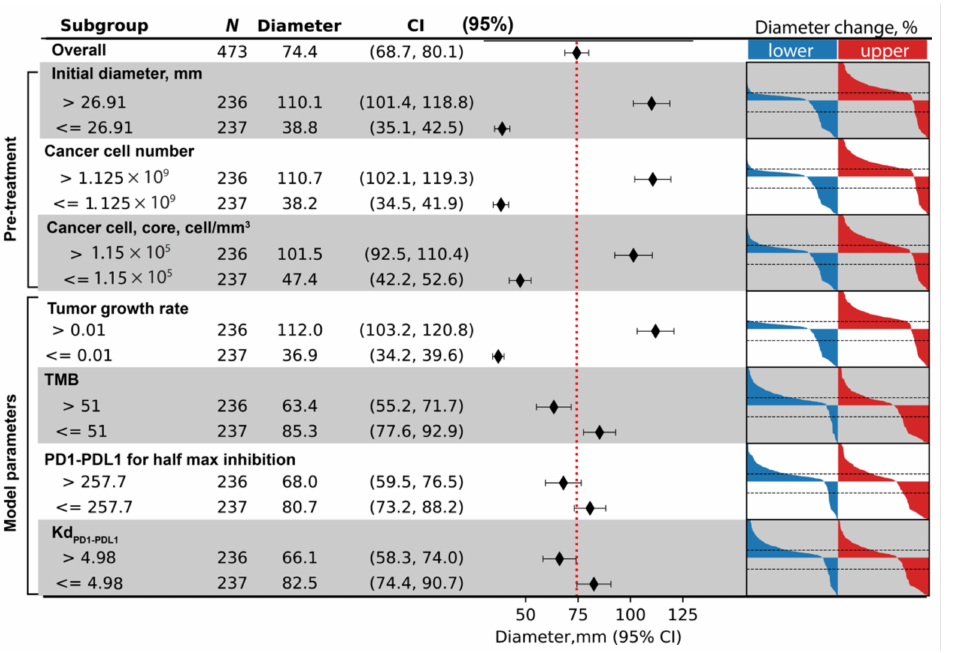
Figure 9. Tumor diameter in patient subgroups based on indicated biomarkers. On the right-hand side, waterfall plots are shown of the lower and upper half of the virtual population with regard to each